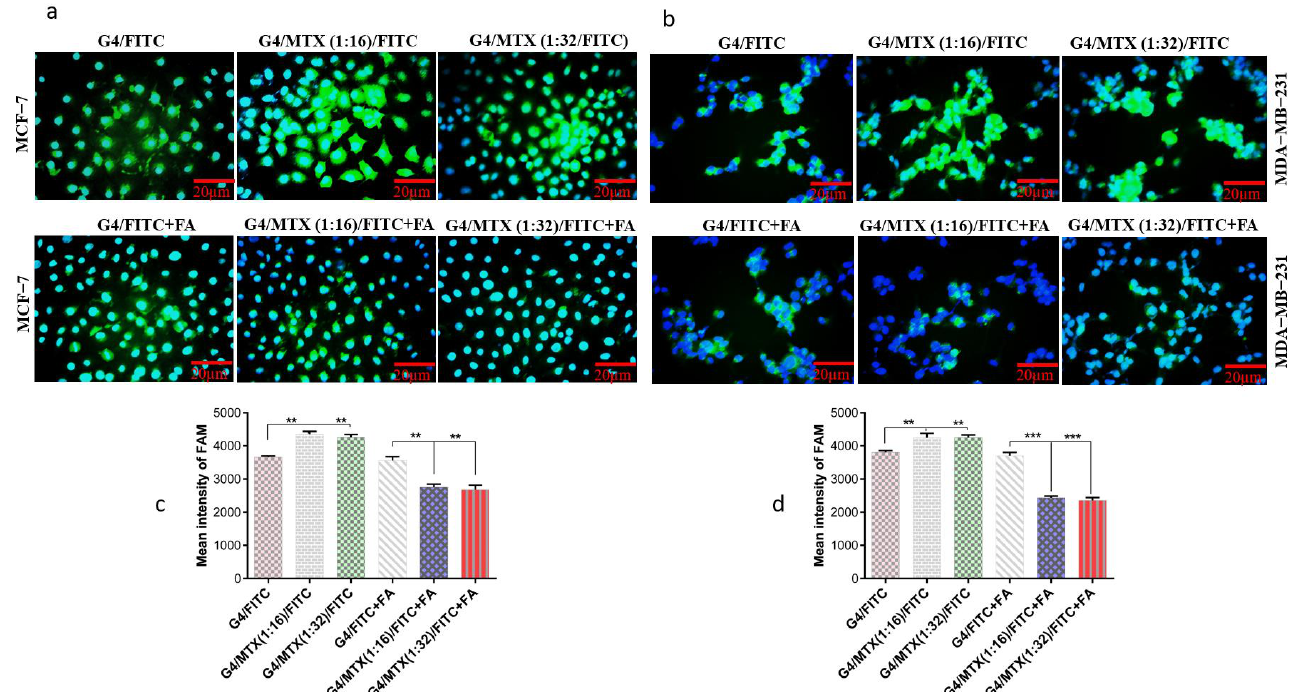
Figure 2. Intercellular uptake of dendrimers carriers by FR expressing cancer cells. Fluorescence microscopy images (scale bar 20 µm) of MCF-7 cells ( a ) and MDA-MB-231 cells ( b ) that incubated for 4 h with FITC-labeled G4 dendrimer, G4/MTX (1:16) and G4/MTX (1:32) in the absence and presence of FA (1 mM). Blue and green represent DAPI stained nucleus and FITC-labeled dendrimer carriers respectively. MFI quantified cellular uptake in the absence and presence FA (1 mM) for MCF-7 cells ( c ) and MDA-MB-231 cells ( d ) when cells were treated with FITC-labeled G4 dendrimer and G4/MTX (1:16 and 1:32) nanosystems. The data were expressed mean ± SD ( n = 3). Significance: ** p values < 0.01; *** p values < 0.001.